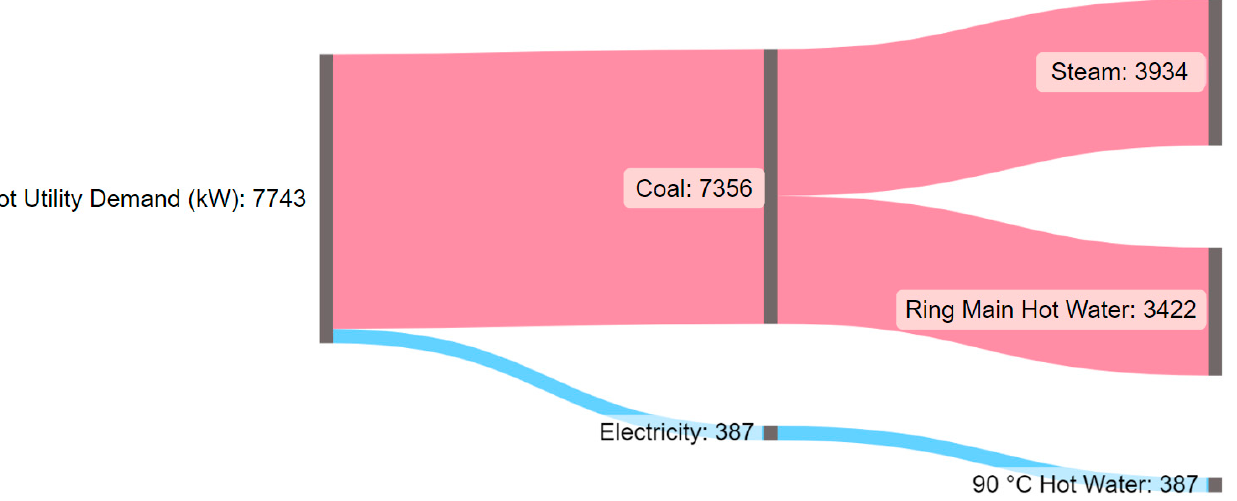
Figure 3. Sankey diagram of case study process heat sources and uses in MW. Table 1. Summary of results from TSHI of case study site